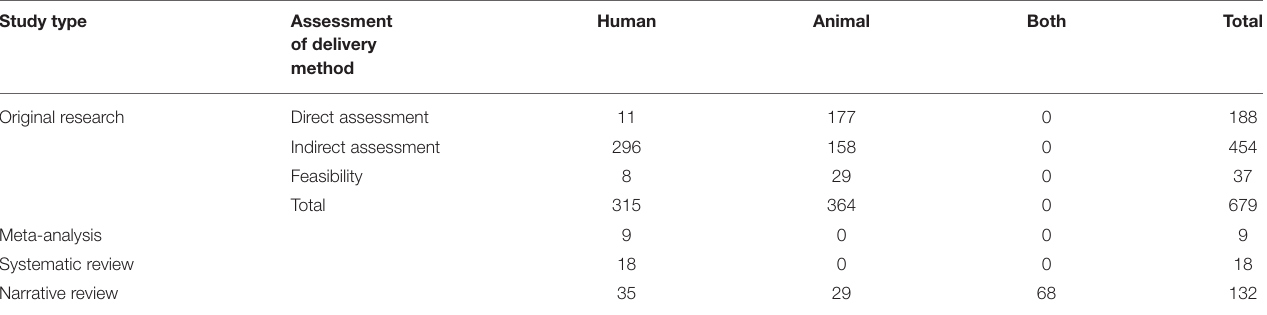
TABLE 5 | Study design and assessment of delivery